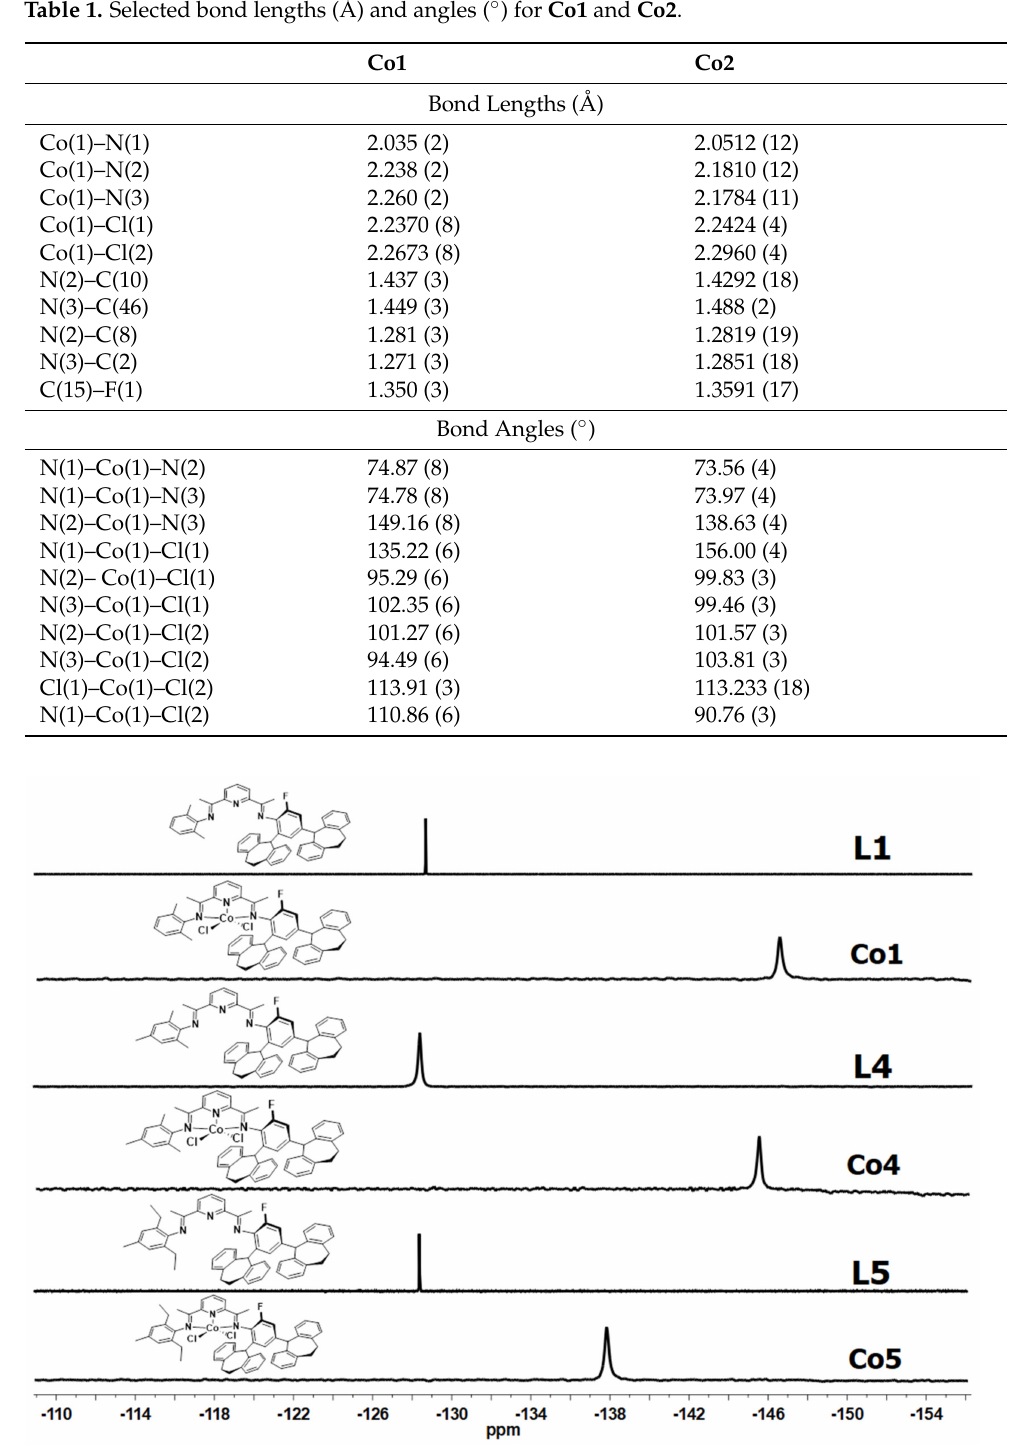
Table 1. Selected bond lengths (Å) and angles ( ◦ ) for Co1 and Co2 .